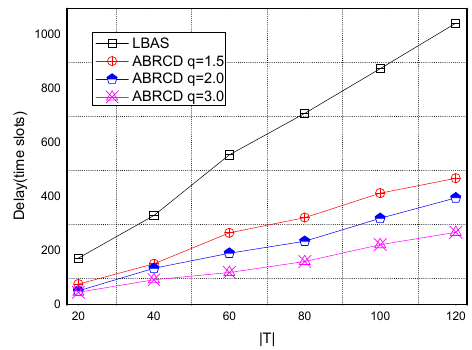
Figure 38. The impact of | T | with fixed network size = 200 on delay. Sensors 2018 , 18 , x FOR PEER REVIEW